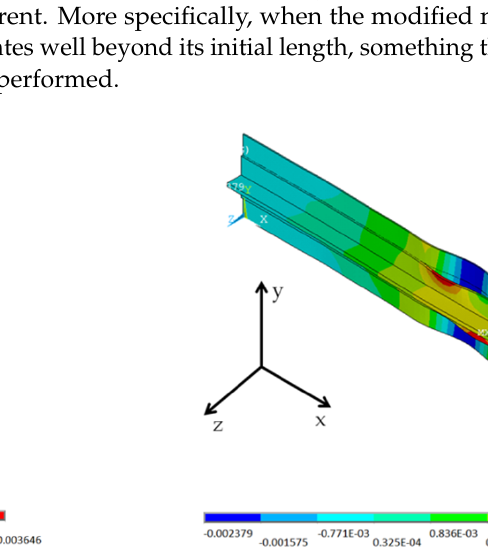
Figure 3. ( a , b ) FE contour plot of the out-of-plane displacement at the end of the loading when ( a ) the maximum normal and shear traction parameters are modified and ( b ) when they are not.